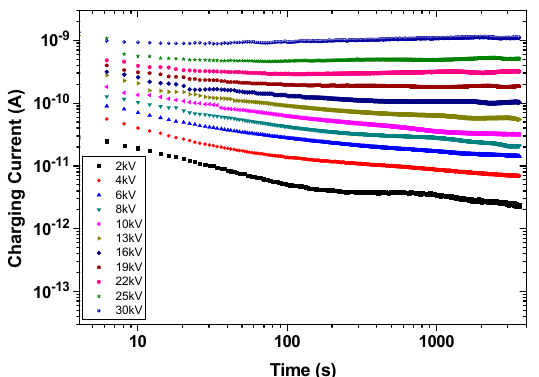
Figure 6. Charging current transients under different fields at a temperature of 50 °C. Currents were measured in 2 s intervals all along the cycle.